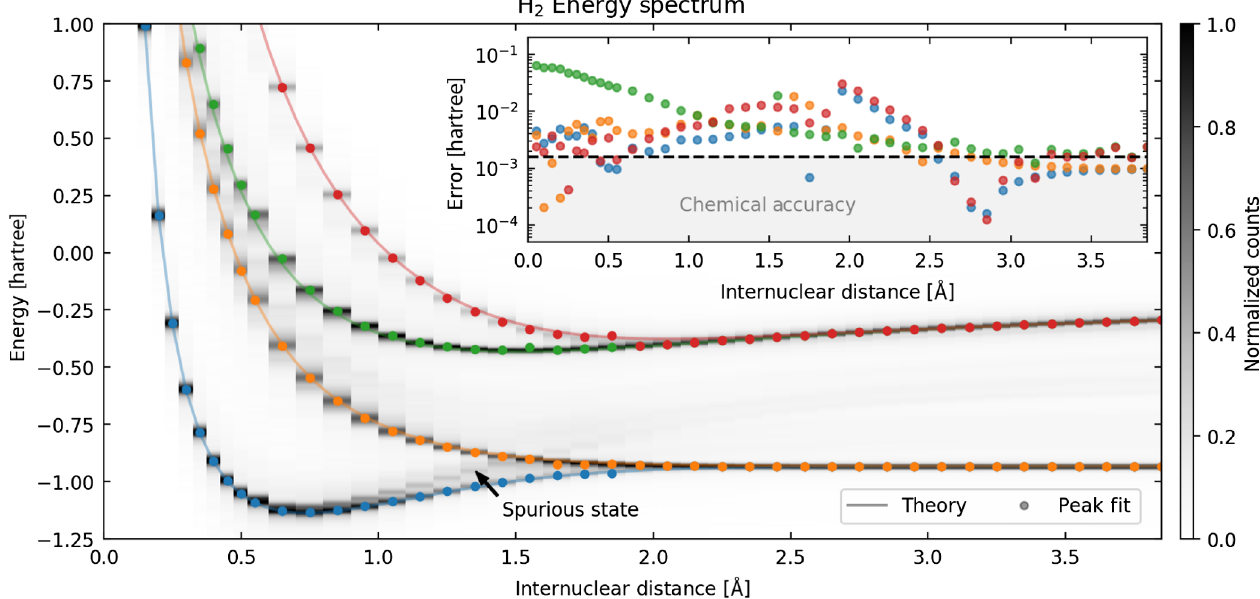
FIG. 3. H 2 energy spectrum as a function of internuclear distance. Swarm particle energies for each bond length are histogrammed after application of a linear-response expansion and Gaussian filter. Energy estimates obtained by a peak finding routine are indicated by dots with theoretically predicted energy levels shown as solid lines. An unphysical spurious state emerges at internuclear distances greater than ∼ 1 . 2 Å due to uncorrected incoherent errors. Inset shows errors in the estimated ground- and excited-state energies as compared to chemical accuracy ( 1 . 6 × 10 − 3